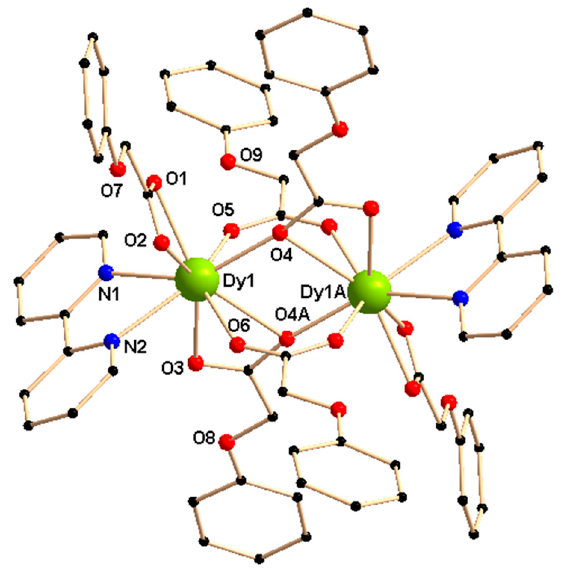
Figure 1. Crystal structure of [Dy 2 (L 1 ) 6 (L 2 ) 2 ] · 2EtOH ( 1 ). Solvent ethanol molecules are deleted for clarity. Symmetry, A, – x , – y , 2– z .